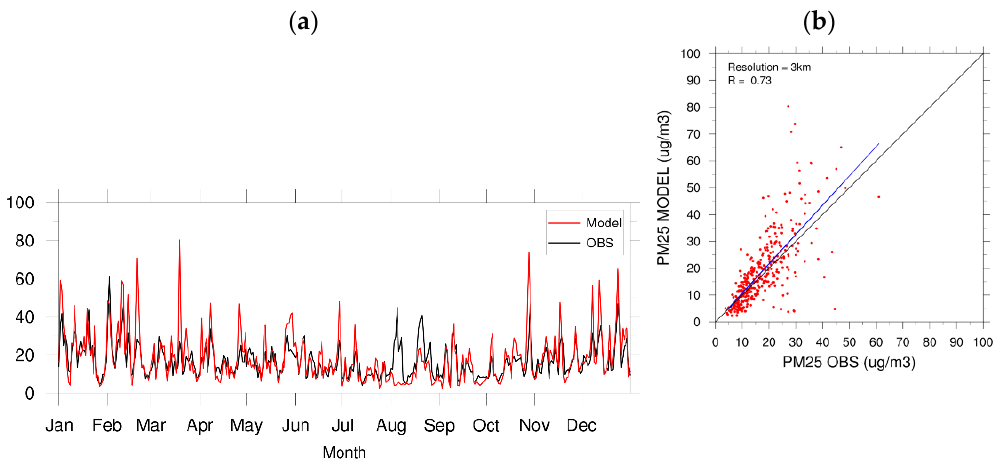
Figure 3. ( a ) Time series and ( b ) scatter plots of PM 2.5 levels between measured data in the Busan